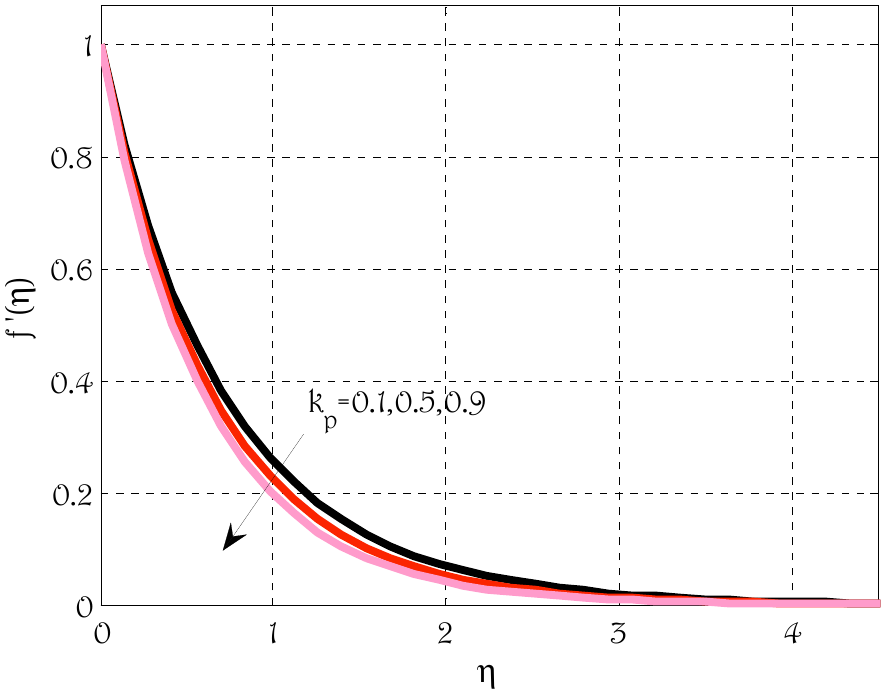
Figure 4. Effect of porosity parameter k p on velocity profile f (cid:48) using λ = 0.1, M = 0.5, R d = 0.7, P r = 1.9, E c = 0.1, N b = 0.1, N t = 0.1, S c = 1.4, γ = 0.1.